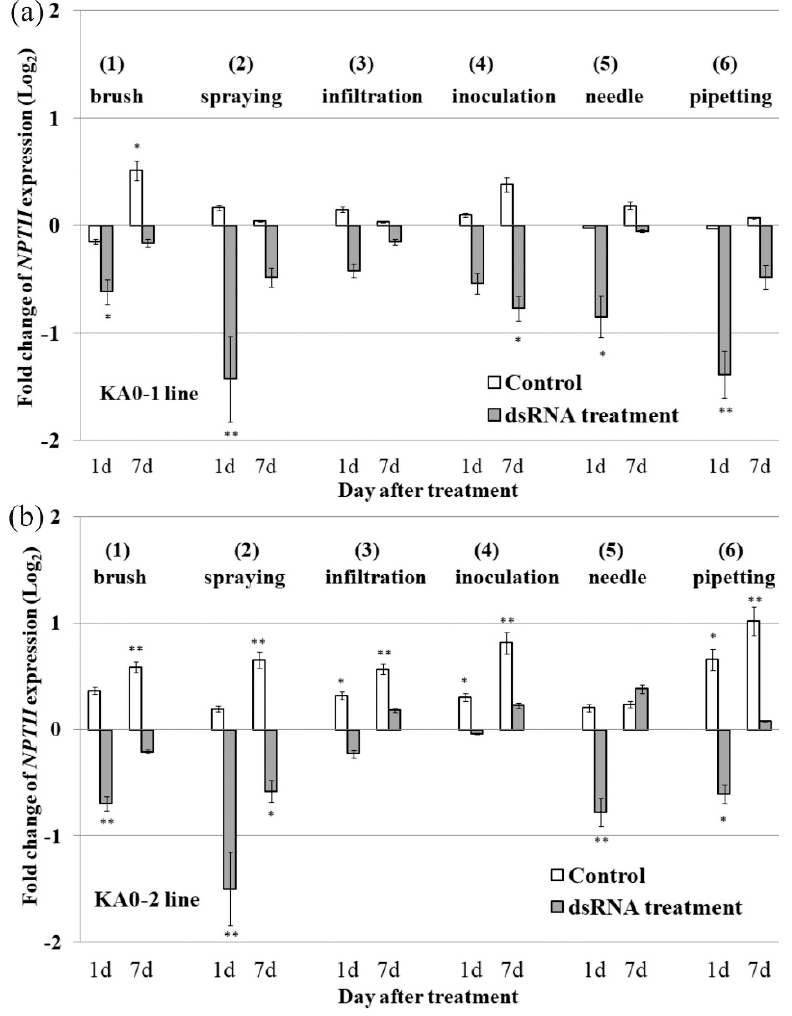
Figure 3. The effect of different dsRNA application methods on dsRNA-induced NPTII downregulation in 4-week-old Arabidopsis thaliana . Quantification the NPTII mRNA levels (log 2 ) in the KA0-1 ( a ) and KA0-2 ( b ) lines of A. thaliana in response to foliar application of sterile filtered water (control) or NPTII -encoding dsRNA (dsRNA treatment) relative to NPTII mRNA level in the same plants before treatments. The dsRNAs were applied by (1) spreading with individual soft brushes; (2) spraying with a 2 mL atomizer; (3) syringe infiltration; (4) mechanical inoculation; (5) needle injection; (6) pipetting by an automatic sampler. All leaves of one rosette for each type of condition were treated on both the adaxial (upper) and abaxial (lower) and sides, except for and needle (upper) and infiltration (lower). The leaf surface of each individual plant was treated with 0.35 µg/µL of NPTII - ds RNA or water (100 µL per individual plant). RNA was isolated from the same individual plant before, 1 day, and 7 days after treatments (two independent experiments). qRT-PCR data are presented as mean ± SE. *, **—significantly different from the untreated plant at p ≤ 0.05 and 0.01, respectively, according to the Student’s t -test.